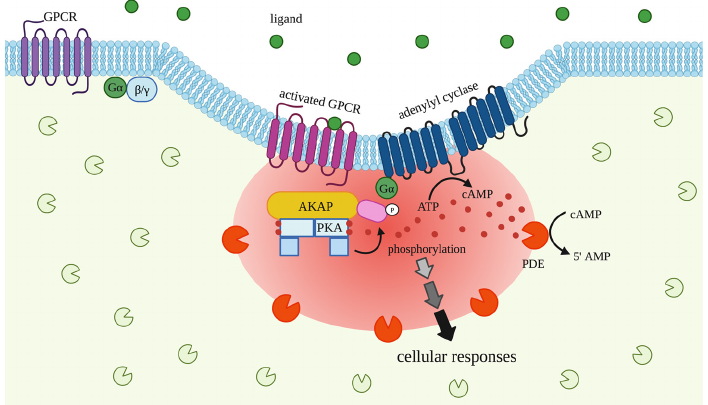
Figure 1. cAMP signaling domain at the plasma membrane. The schematic shows the key components of cAMP signaling, starting from a ligand binding to a specific GPCR at the plasma membrane. Receptor-ligand binding triggers a conformational change in the receptor (light purple), leading to GPCR-G protein interaction, which ultimately induces the release of α subunit of G protein (G α ) and production of cAMP by the enzyme adenylyl cyclase (blue). The local cAMP pool generated on activation of AC is represented as the red-shaded oval. The specificity in the translation of the message is ensured by the spatial constrain of the cAMP signal and by the scaffolding protein AKAP that tethers the major cAMP effector, PKA, to the site of cAMP production. Anchored PKA subsets are activated by a high concentration of cAMP to specifically phosphorylate only substrates localized in the vicinity. The amplitude and duration of the cAMP signal are shaped by the domain-associated PDEs (red Pac-Man symbols). Other cAMP compartments remain in the basal state, and their cAMP level is maintained at a low level by different pools of PDEs (light green Pac-Man symbols). The figure was created with Biorender.com.